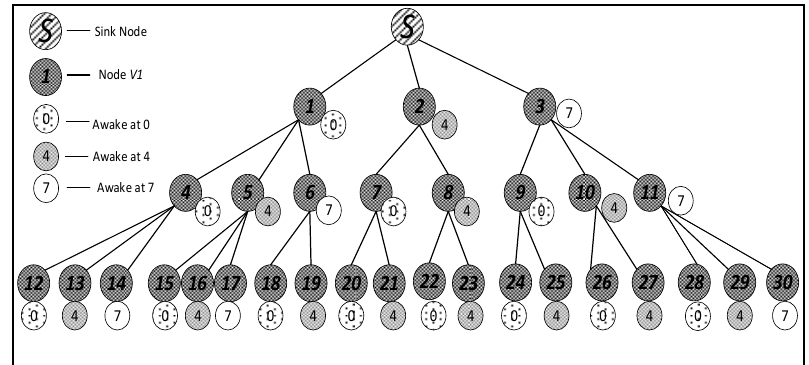
Figure 2. Networks topology.